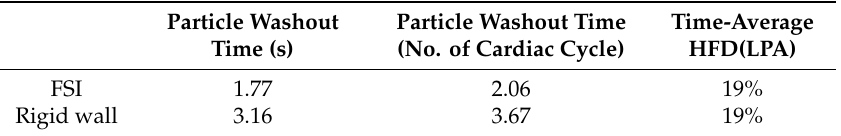
Figure 13. Distribution of the residence times for particles injected at the inferior vena cava: ( a ) fluid-structure interaction (FSI) simulation and ( b ) rigid wall simulation. Table 5. Comparison of particle washout time and time-averaged hepatic flow distribution to the left